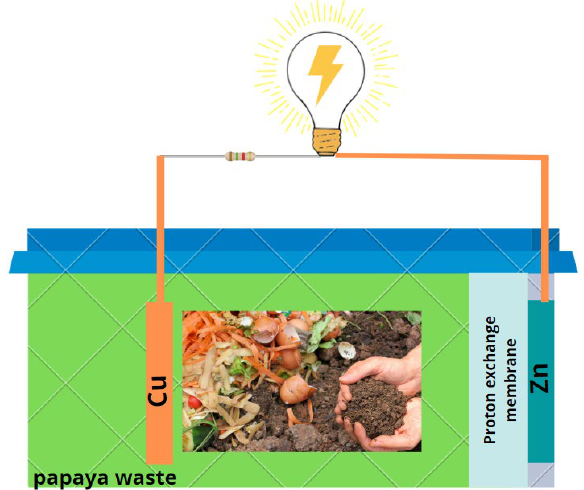
Figure 7. Schematization of single-chamber microbial fuel cells.